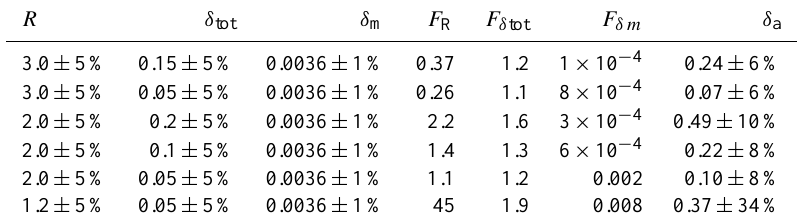
Table 2. Illustrates the systematic uncertainty in the linear particle depolarization ratio propagated from the systematic uncertainties in total aerosol scattering ratio, linear volume depolarization ratio, and linear molecular depolarization ratio. Benchmark values of R (total aerosol scattering ratio), δ tot (the volume depolarization ratio) and δ mol (the molecular depolarization ratio) and typical systematic uncertainties are given in the first three columns. Columns 4–6 give the propagation factors, as described in the text. Column 7 gives the resulting particle depolarization ratio and systematic uncertainty for each benchmark set. Note: percentages given in this table are relative uncertainties (not depolarization ratio